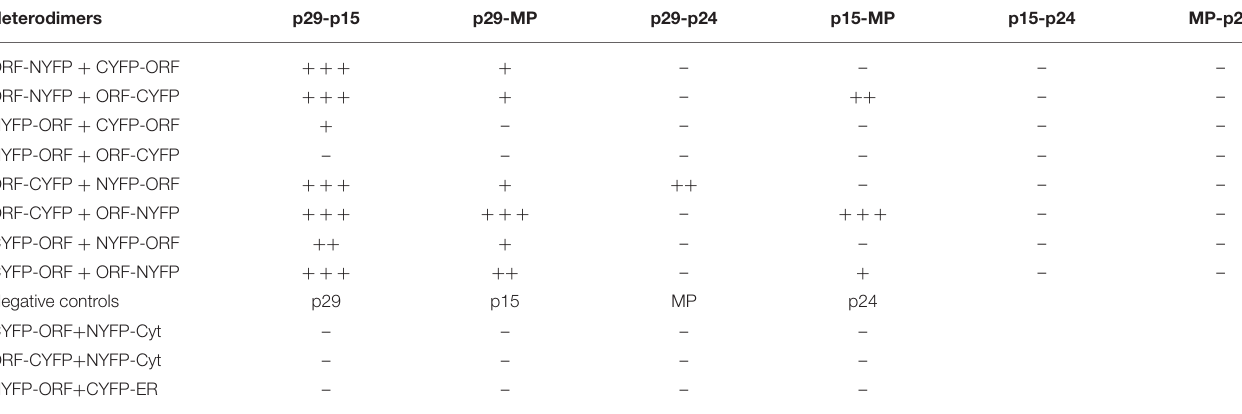
TABLE 2 | Synthesis of all protein pair combinations performed in the BiFC hetero-dimerization assay.